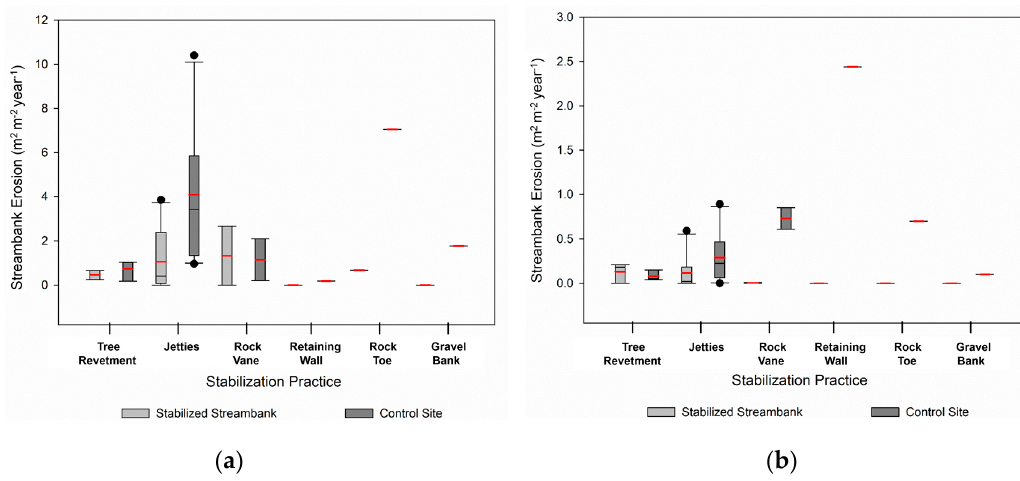
Figure 7. Streambank erosion rate for the flood period (2009–2010) ( a ) and post-flood period (2010–2016) ( b ) for the stabilized streambanks and control sites.